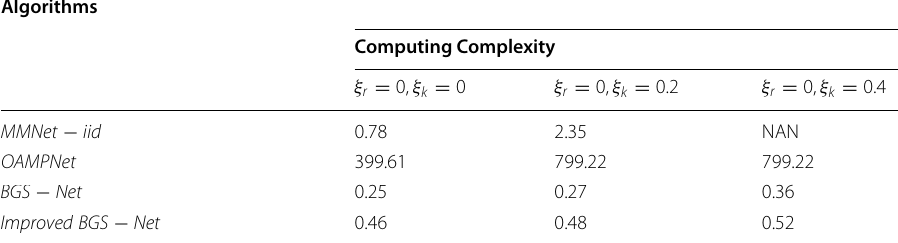
Table 3 When N t = 16,N r = 128 , the required complexity corresponding to Figure 28 (calculated according to Table 1, based on the complexity of MMSE, NAN indicates that the performance cannot be achieved at this